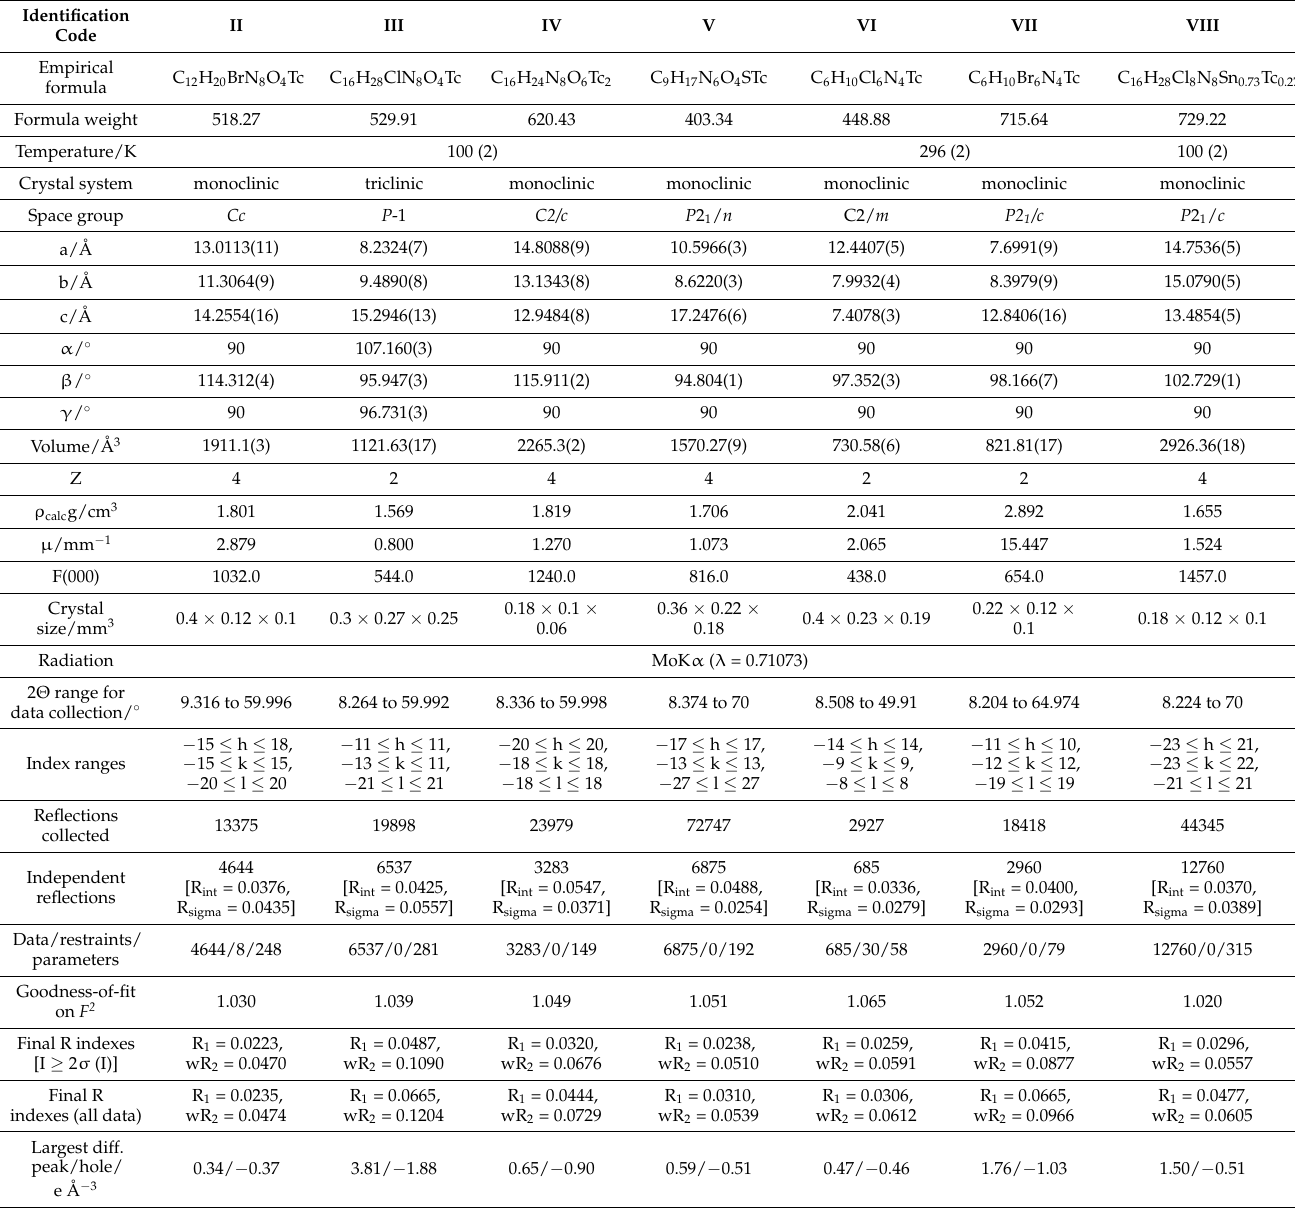
Table 3. Crystal data and structure refinement for structures II – VIII